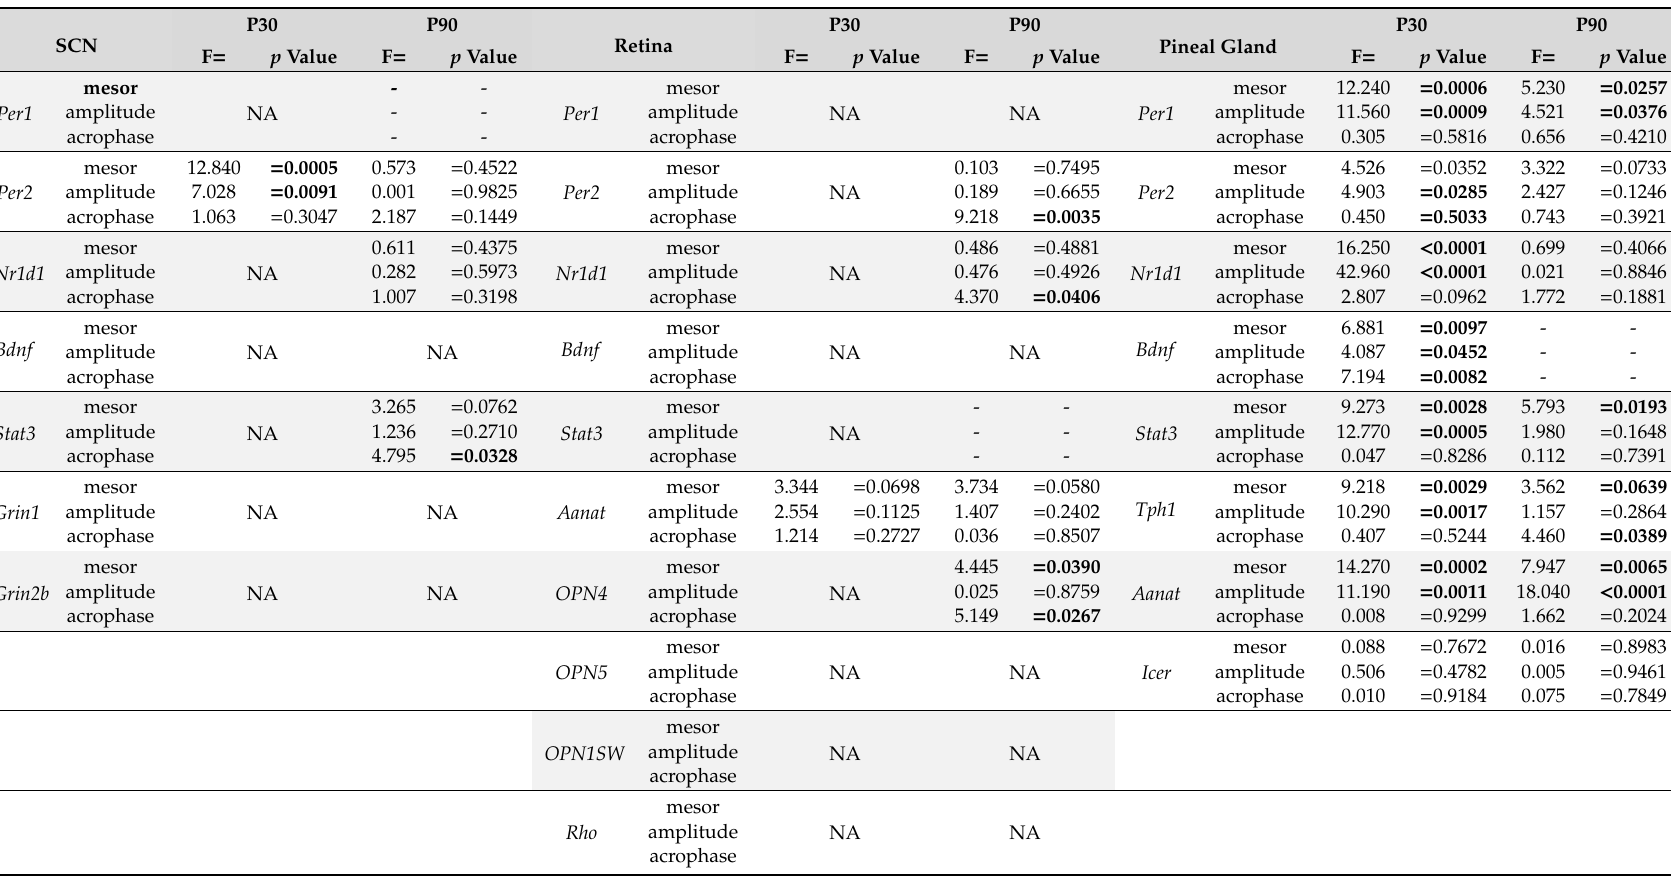
Table 2. Di ff erences in cosinor parameters between control and LL-reared rats in SCN, retina, and the pineal gland, revealed by one-way ANOVA followed by Tukey’s multiple comparisons test. Significant values are in bold. Dashes indicate missing values. NA (not applicable) indicates that one or both profiles were not rhythmic and cosinor parameters could thus not be calculated (see Figures 2–7 for